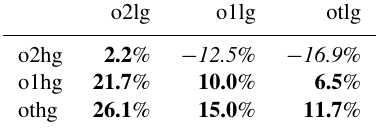
Table 4. Results (in percentage) of the comparisons of the high- resolution products “ophg” with the low-resolution products “oplg”. Positive (bold) numbers mean an improvement, and negative (italic) values represent a reduction in the quality. o2lg o1lg otlg o2hg 2.2 % − 12.5 % − 16.9 % o1hg 21.7 % 10.0 % 6.5 % othg 26.1 % 15.0 % 11.7 %